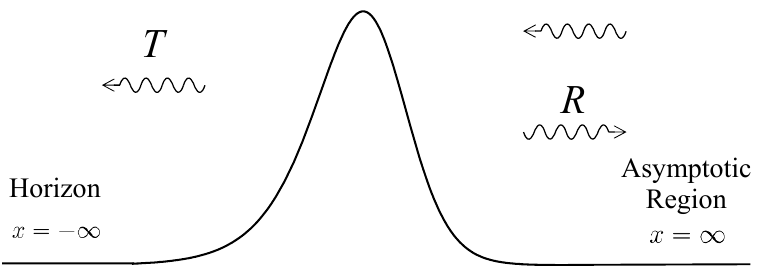
Figure 1 . BH Scattering in tortoise coordinates. A wave arriving from the asymptotic region ( x = 1 ) is scattered o(cid:11) the potential. At high energies, most of the wave reaches the horizon ( x = (cid:0)1 ) and absorbed by the BH, while a small fraction ( R (cid:28) 1) is re(cid:13)ected back. Kruskal coordinates in the following